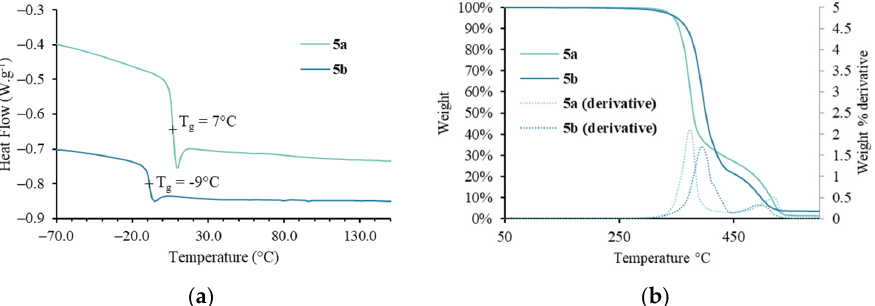
Figure 3. Thermal analysis of 5a and 5b : ( a ) DSC measurement, heating rate 10 °C/min, data have been offset one from another by − 0.5 W.g − 1 ; ( b ) TGA measurement under air at a heating rate of 10 °C/min.